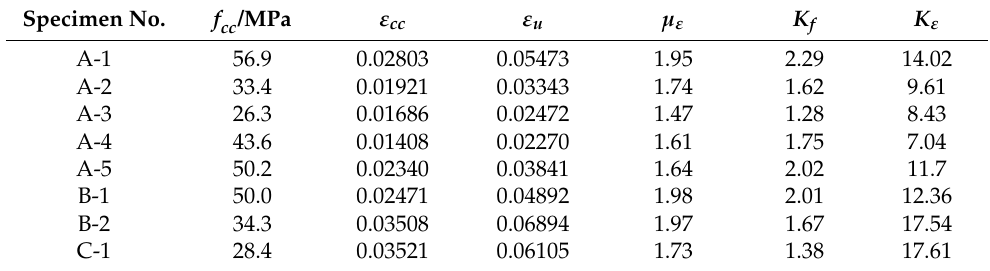
Table 3. Test result.